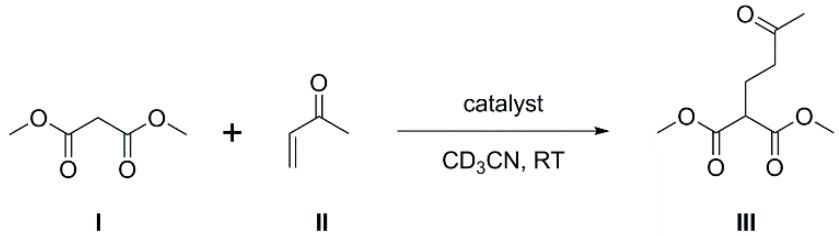
Table 1. Results for catalysis of the Michael addition reaction in Scheme 1 by PPh 3 , the FLP 1 /PPh 3 and V . 1 Entry Catalyst(s) Time (h) Yield (%) 2